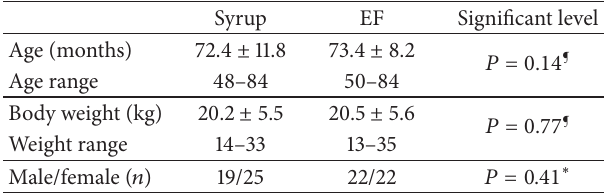
Table 1: Demographic characteristics of